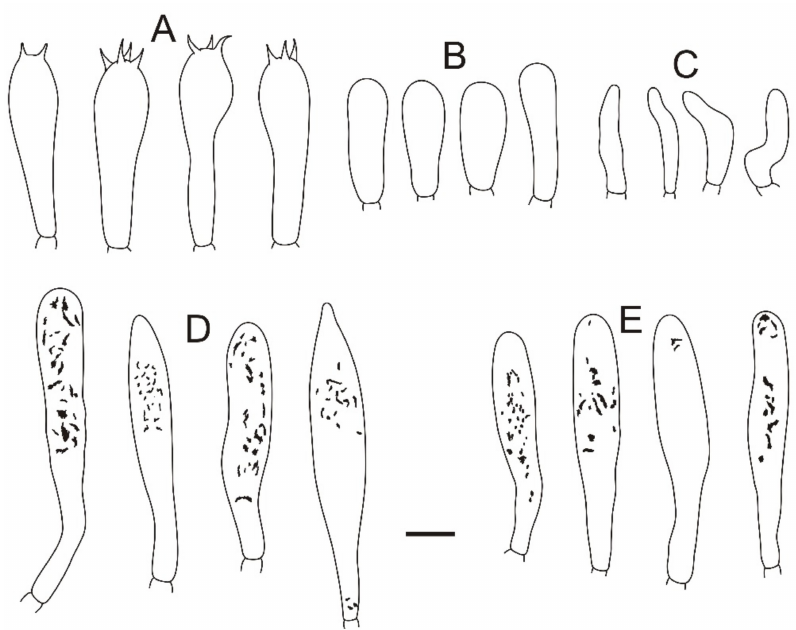
Figure 4. Microscopic features of Russula miyunensis (BJTC Z1355). ( A ) Basidia. ( B ) Basidiola. ( C ) Marginal cells. ( D ) Hymenial cystidia on lamellae sides. ( E ) Hymenial cystidia on lamellae edges. Scale bar: 10 µ